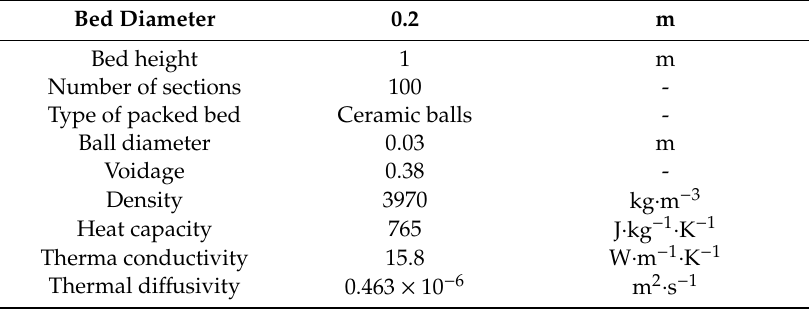
Table 5. The geometry of the regenerator and properties of the packed